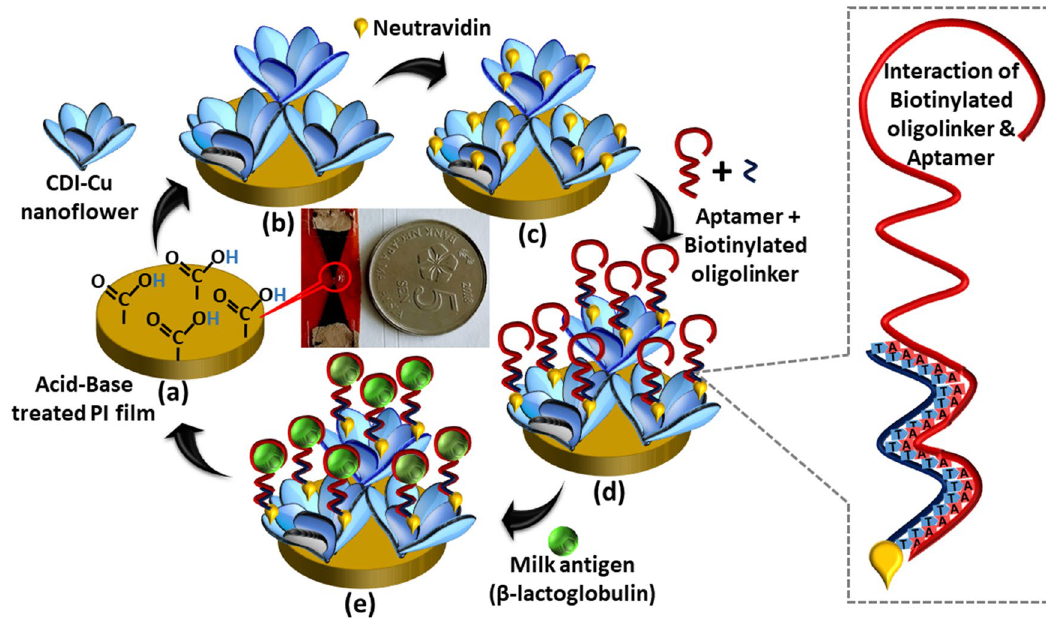
Figure 1. Stepwise fabrication of milk allergen, β-lactoglobulin biosensor on polyimide (PI) film, ( a ) acid–base treatment to terminate carboxylic functional group, ( b ) deposition of CDI-Cu hybrid NF, ( c ) modification with neutravidin, ( d ) immobilization of oligoaptamer, and ( e ) detection of